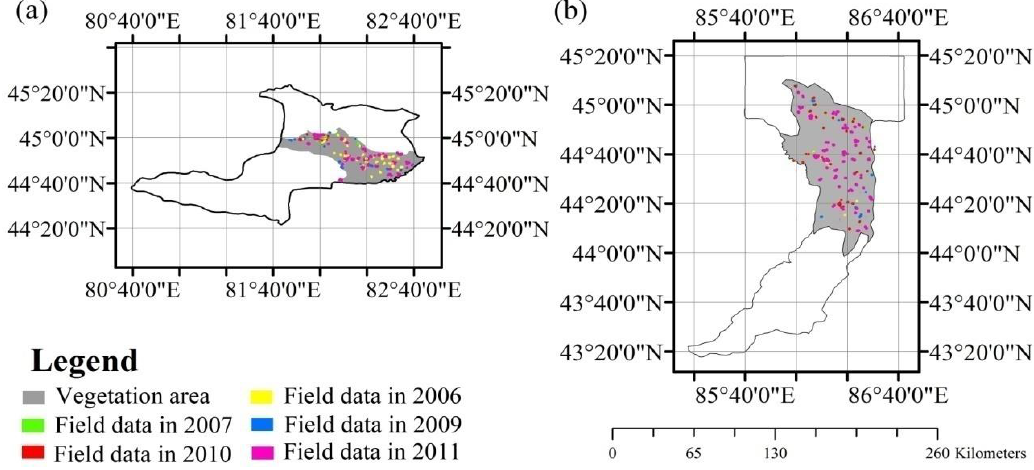
Figure 2. Distributions of ground reference data: ( a ) Bole; and ( b ) Manas.